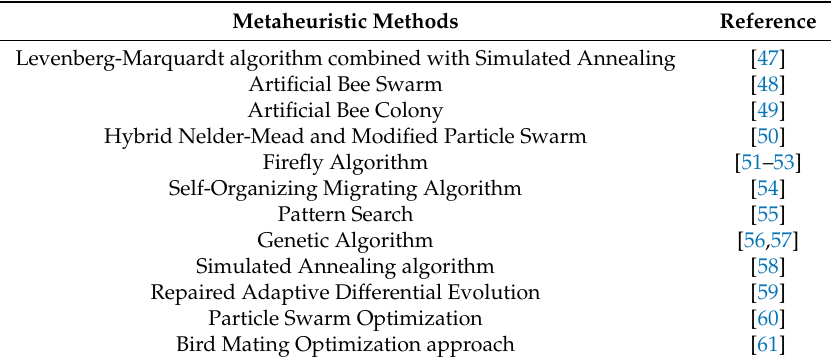
Table 2. A list of metaheuristic methods employed in the